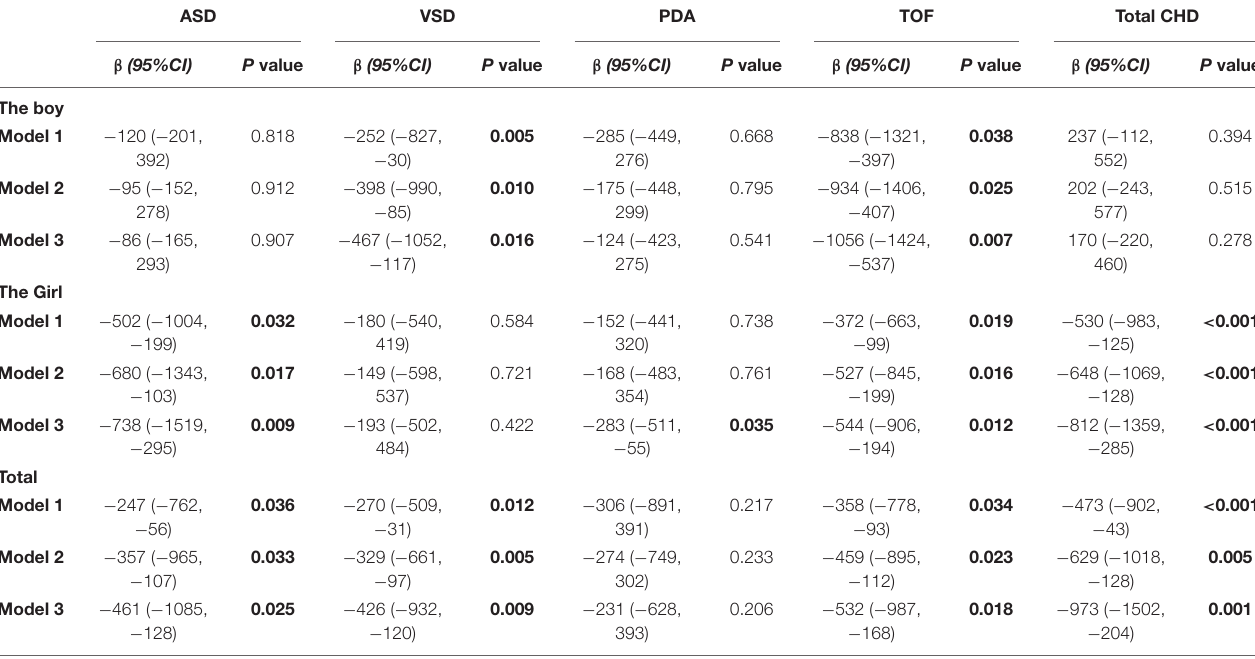
TABLE 4 | Generalized linear model results of the relationship between different subtypes of congenital heart disease and birth weight in children.* ASD VSD PDA TOF Total CHD